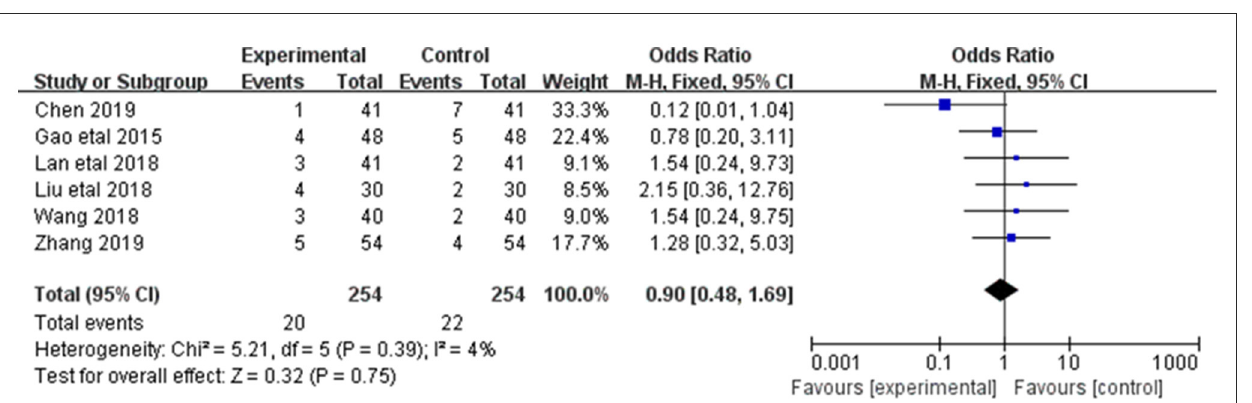
FIGURE9 Forest plot of analysis of the adverse reactions of treating CHF.